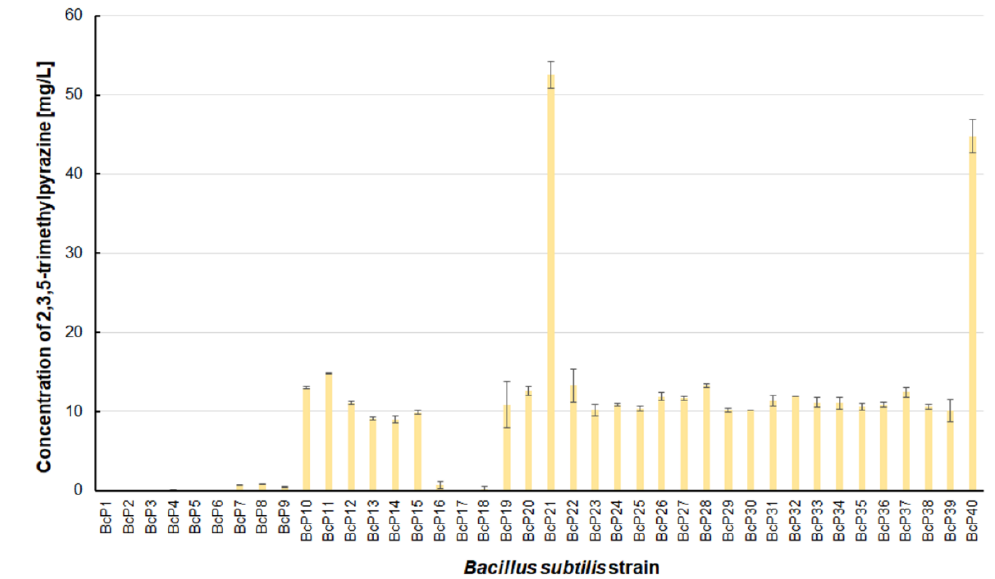
Figure 7. The 2,3,5-trimethylpyrazine biosynthesis by B. subtilis strains.